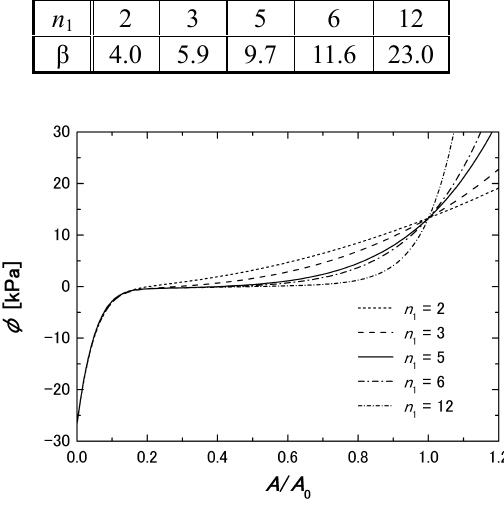
Fig. 9 Variation of tube law by n 1 .